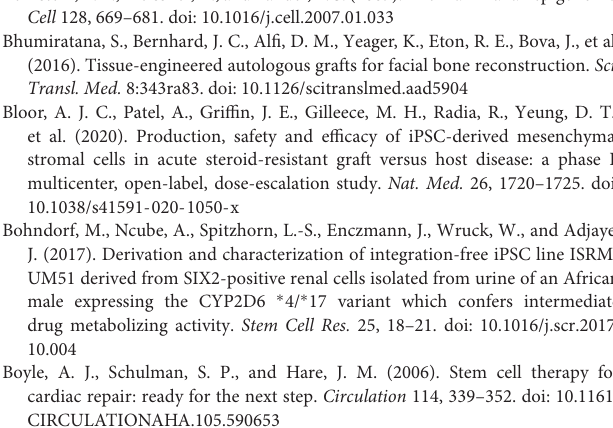
Supplementary Table 1 | Subsets and GO analyses of relevant subsets of the venn diagram of fetal MSCs, iMSCs, adipose-tissue-MSCs, bone-marrow-MSCs and UC-MSCs ( Figures 2 and 3 ). (A) subsets of genes, (B) Significant GO terms in fetal MSCs (401 genes), (C) Significant GO terms in UC-MSCs (558 genes), (D) Significant GO terms in iMSCs (374 genes), (E) Significant GO terms in adipose-tissue-derived MSCs (29 genes), (F) Significant GO terms in bone-marrow-derived MSCs (130 genes), (G) Significant GO terms in the intersection of all (9966 genes). Supplementary Table 2 | Subsets and GO analyses of relevant subsets of the venn diagram of amniotic-fluid-derived MSCs (AF-MSCs), urine-derived renal progenitor cells (UdRPCs) and hepatic stellate cells (HSCs) and the common MSC signature determined before ( Figure 4 ). (A) subsets of genes, (B) Significant